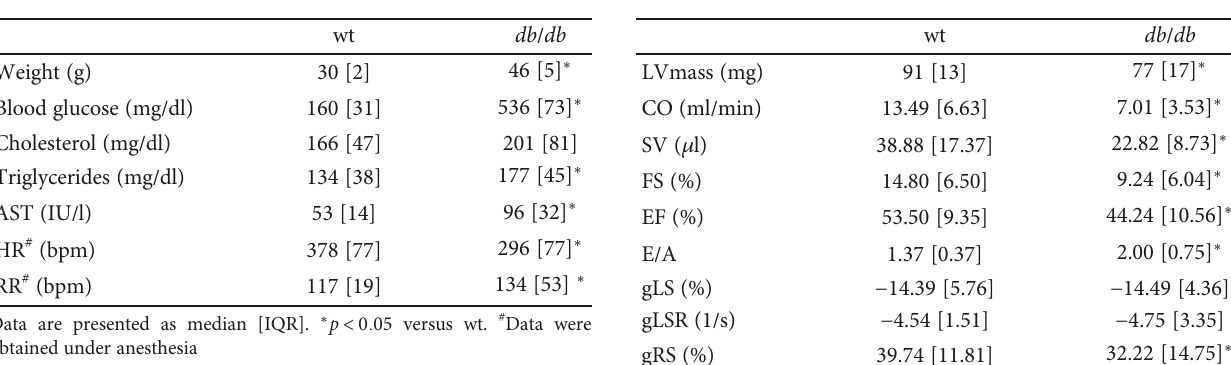
Table 1: Weight and biochemical and physiological parameters in the two groups of mice.